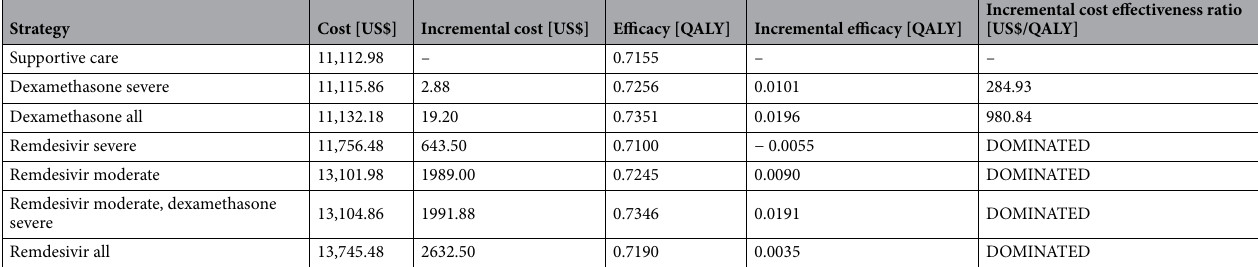
Table 2. Base case analysis referencing supportive care as